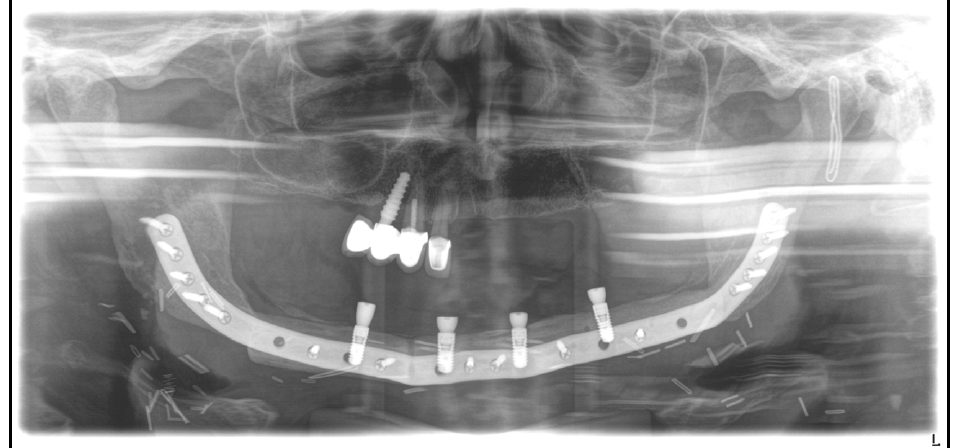
Figure 8. Dental X-ray after implantation of four endosseous implants in the neo-mandible for dental rehabilitation and extraction of the upper first incisor on the right, August 2021.